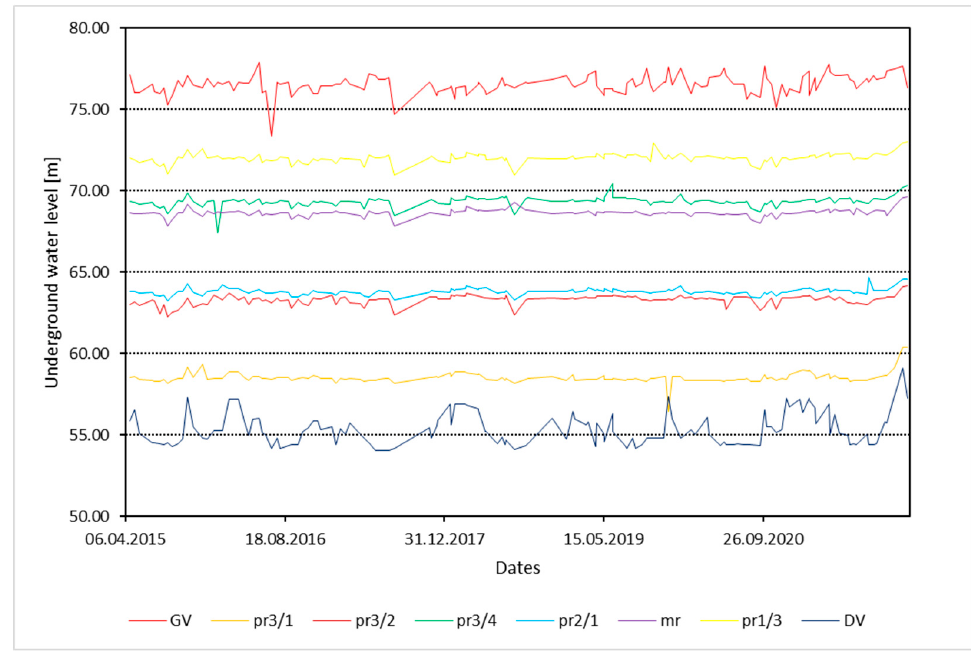
Figure 11. Daily measured values for groundwater level in piezometers, headwater, and tailwater for the period April 2015–December 2021.